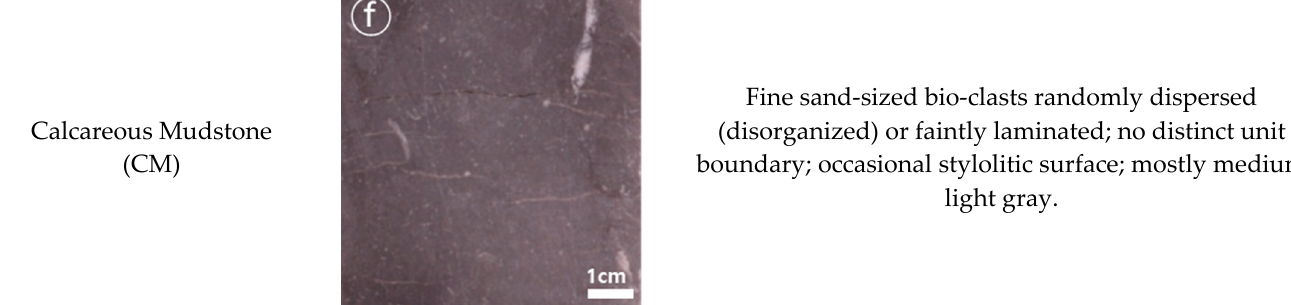
Figure 2. Description of classified core facies and their pictures. The core descriptions and miner- alogical data span a depth range of 2307.6–2469.95 m. ( a ) Faintly laminated siliceous mudstone (FLSM), ( b ) Homogeneous siliceous mudstone (HSM), ( c ) Laminated siliceous mudstone (LSM), ( d ) Laminated mixed mudstone (LMM), ( e ) Argillaceous Mudstone (AM), ( f ) Calcareous Mudstone (CM) lithofacies.